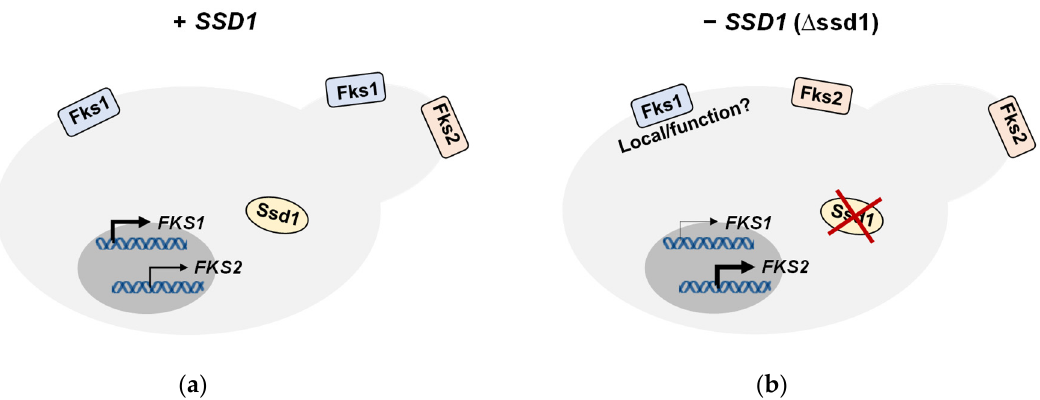
Figure 4. Model displaying the effects on FKS1 and FKS2 gene and protein with ( a ) and without ( b ) SSD1 . These effects are more pronounced within FKS mutants. The Fks1 protein in cells without SSD1 may or may not reach the plasma membrane and/or be functional. Relative, not actual, amount of Fks1/2 protein displayed; model not drawn to scale.